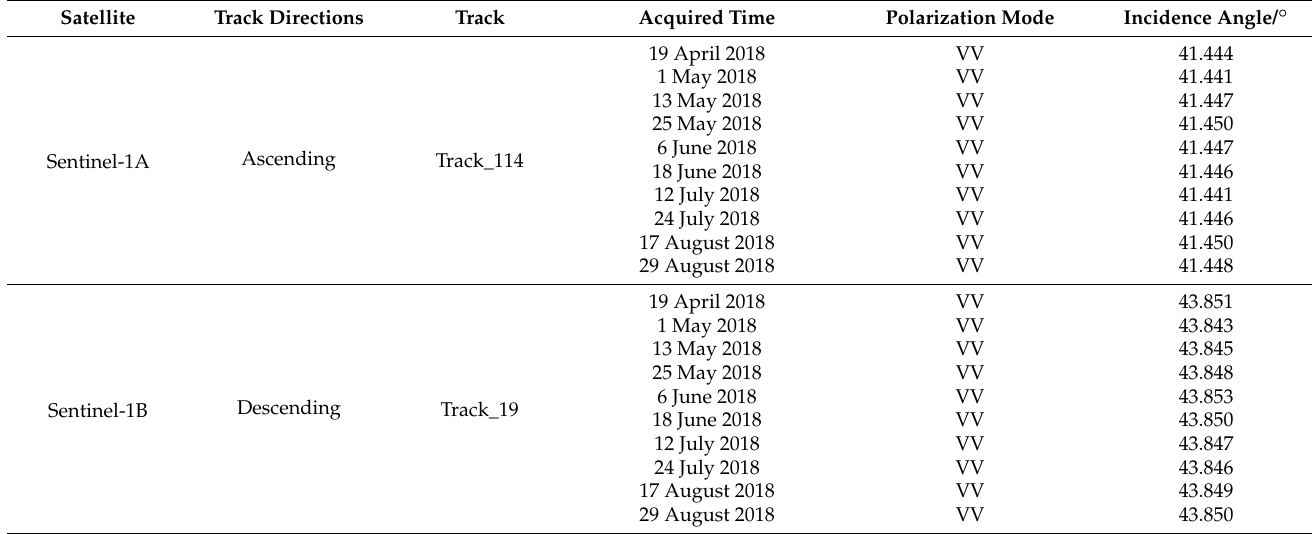
Table A1. Parameter list of Sentinel-1 on Urumqi Glacier No. 1.